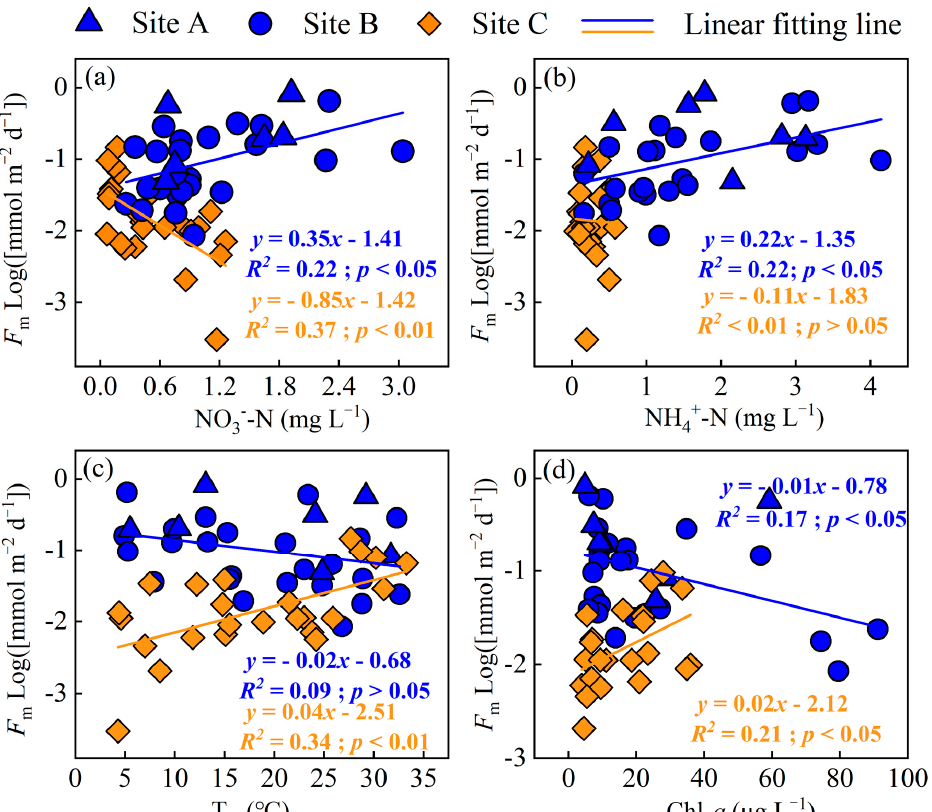
Figure 7. Correlations of the normalized seasonal CH 4 flux against NO 3- -N ( a ), NH 4+ -N ( b ), water temperature (T w) , ( c ), and Chl a ( d ) at the river inlet region (Site A and Site B) and pelagic region (Site C) of the lake from 2012 to 2017. (Triangle represents Site A, circle represents Site B and rhombus represents Site C. Blue represents the river inlet region and orange represents pelagic region.)